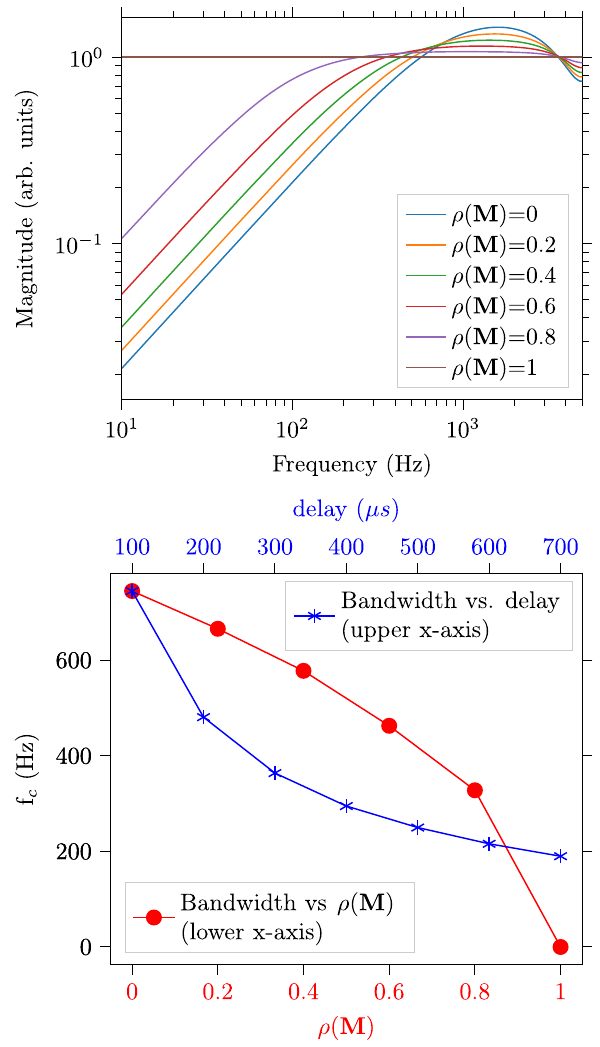
FIG. 14. Top: Sensitivity function of internal model controller (IMC) vs frequency for various values of ρ ð M Þ between 0 and 1. Bottom: Reduction in the cutoff frequency as a function of ρ ð M Þ (lower x -axis) and delay (upper x